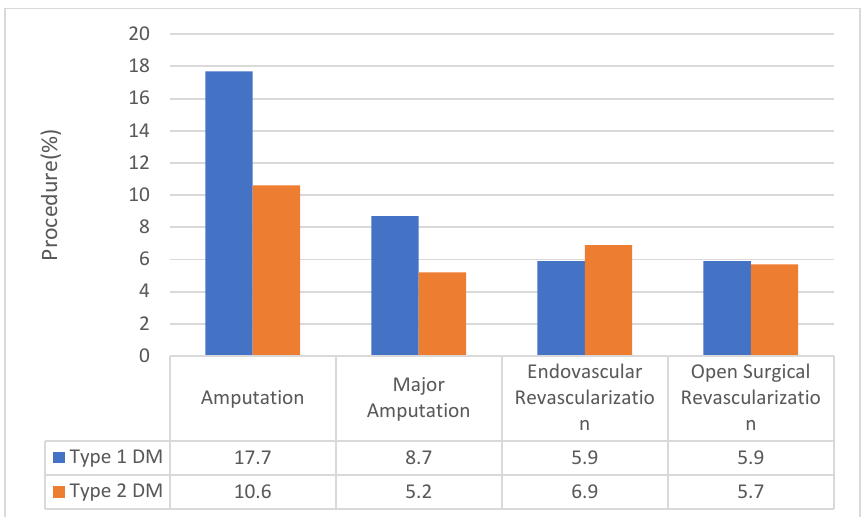
Figure 2. Revascularization procedures utilized based on type of diabetes (type 1 vs. type 2 DM). Y -axis indicates the % of individuals with type 1 or type 2 DM and PAD undergoing a given procedure. The X -axis indicates the type of procedure performed. DM, diabetes mellitus.